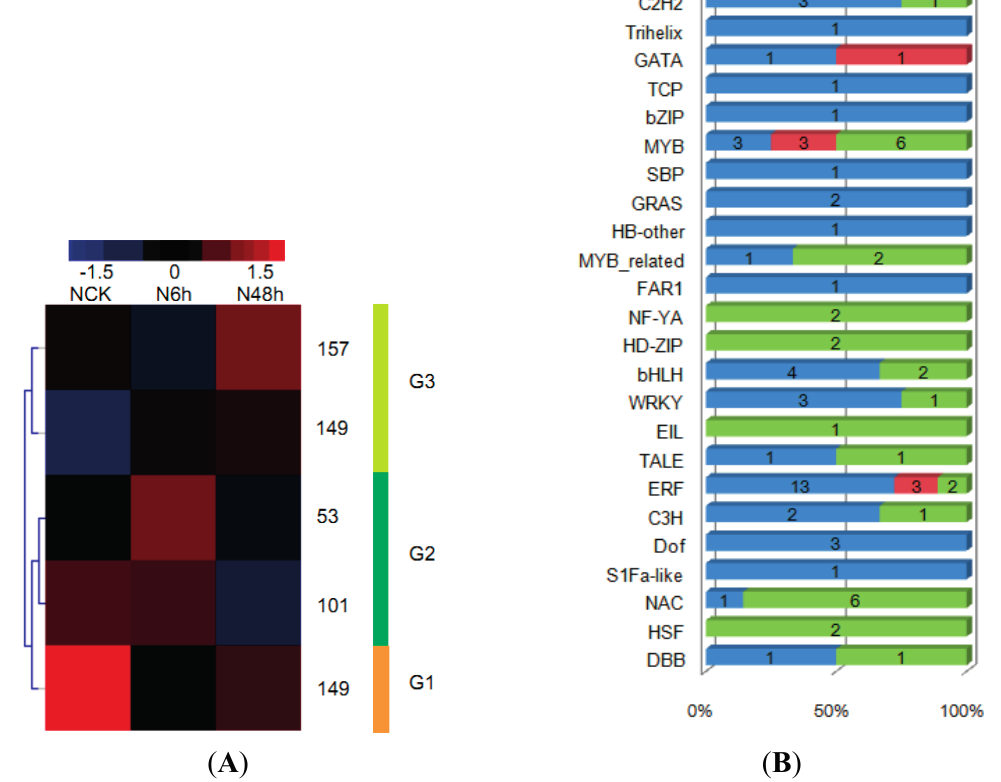
Figure 4. Dynamics of transcription factors in response to drought stress. ( A ) Dendrogram of the transcription factors. 609 expressed transcription factors from NCK, N6H and N48H were identified and clustered into three lineages (G1, G2 and G3) by K -means clustering (see “Materials and methods” for details); ( B ) Distribution of 82 differentially expressed transcription factor families among G1, G2 and